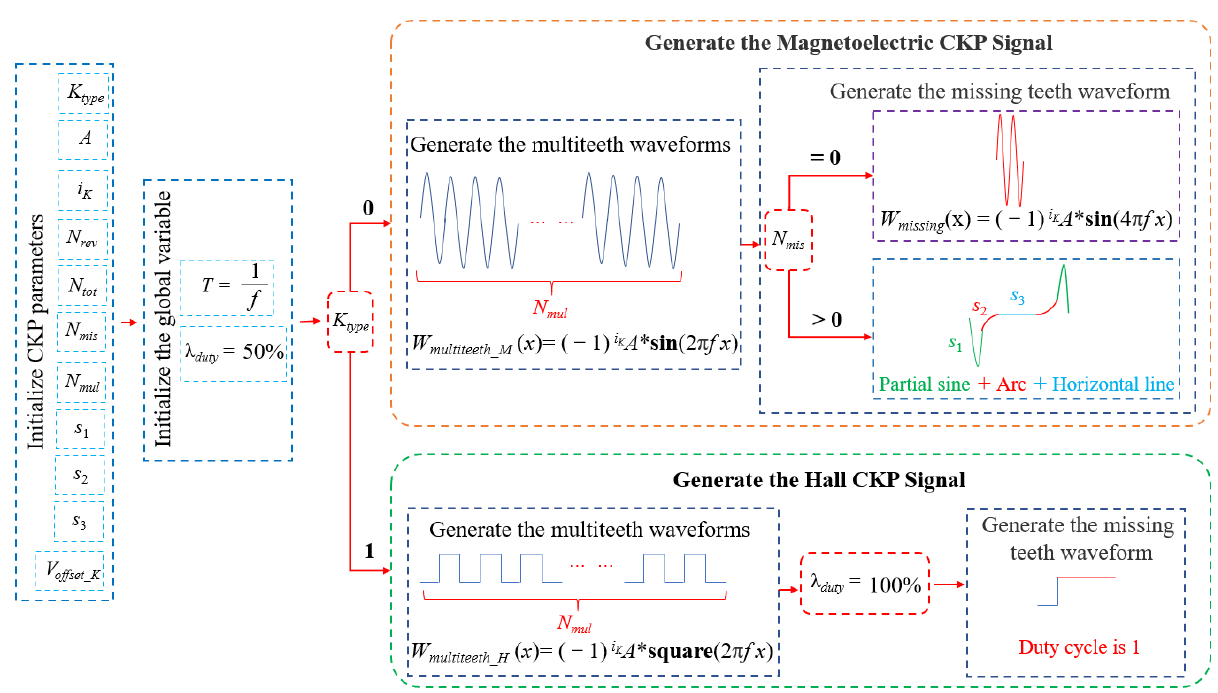
Figure 6. The CKP signal modeling process. T is the period of the signal. f is the frequency of the signal. λ duty represents the duty cycle of the square wave signal.